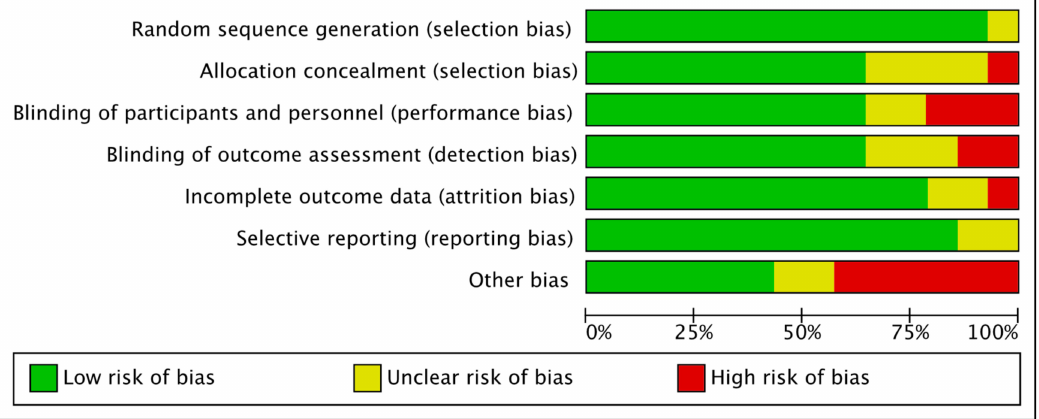
Figure 2. Risk of Bias assessment